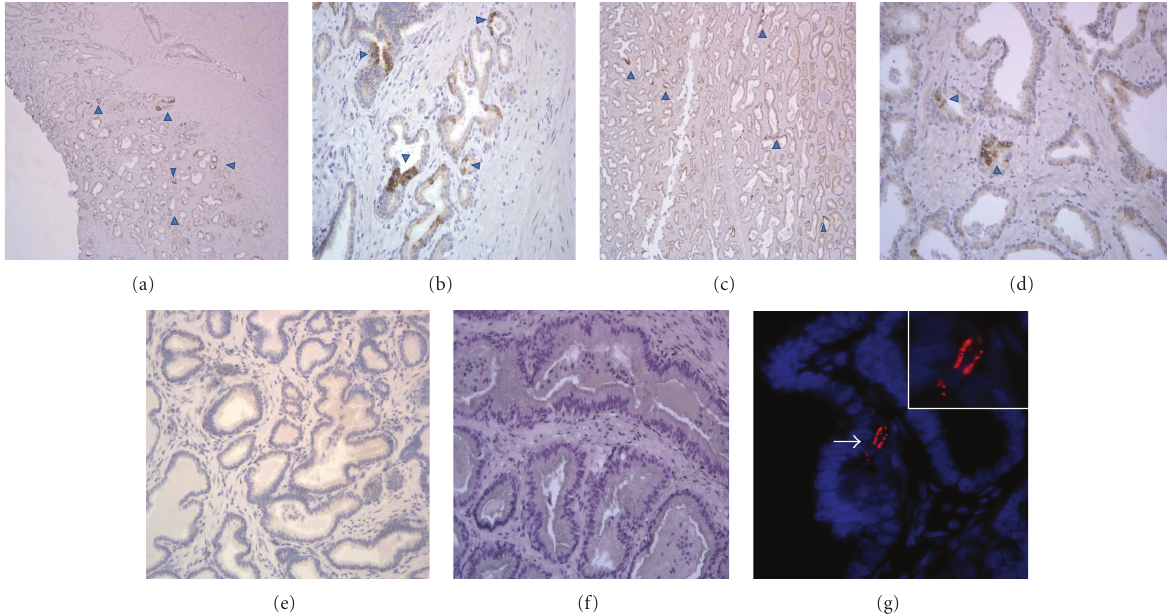
Figure 1: Detection of XMRV gag in the prostates of two acutely infected macaques RLm-1 ((a, b), day 6 pi) and ROu-4 ((c, d), day 7 pi); one chronically infected macaque RLq-10 ((e, f), day 144 pi); control macaque RPd-7 (f). Immunohistochemistry ((a)–(f)). Magnification, × 40 ((a, c)), × 200 ((b, d, e, and f)). FISH (g), magnification, × 600, ×